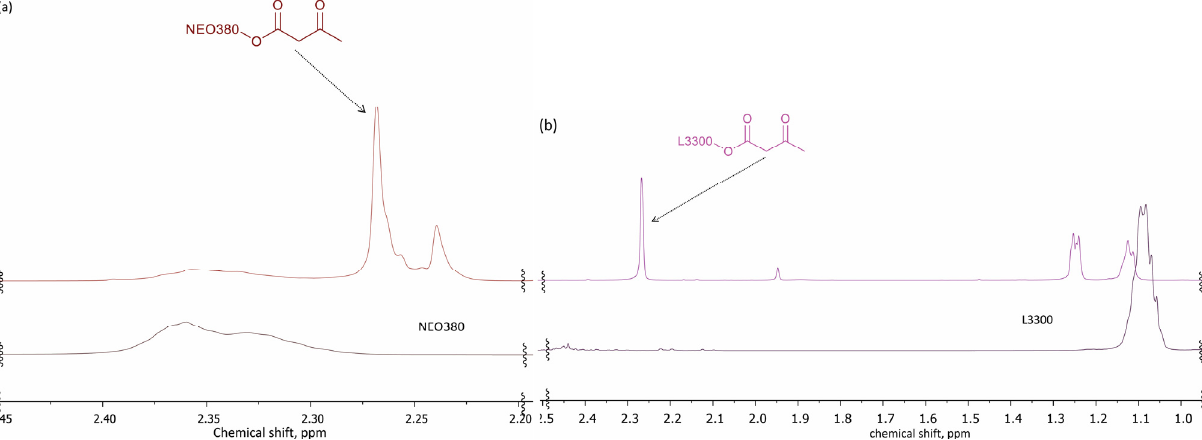
Figure 7. 1 H-NMR spectra of: ( a ) E IR TOFA_BD and E IR TOFA_BD_AA (500 MHz, CDCl 3 ); ( b )